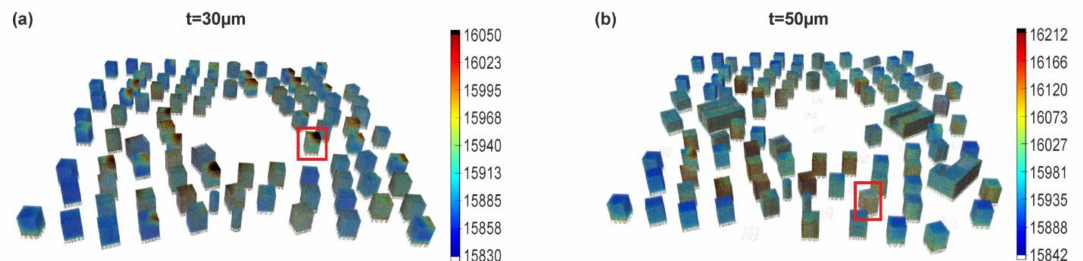
Figure 5. 3D-visualization of area-mean intensity, I 2 , for the two builds ( a ) t = 30 µ m and ( b ) t = 50 µ m. Two specimens are marked with red boxes and will be discussed in detail below. Each shown cuboid measures 10 × 10 × 12 mm 3